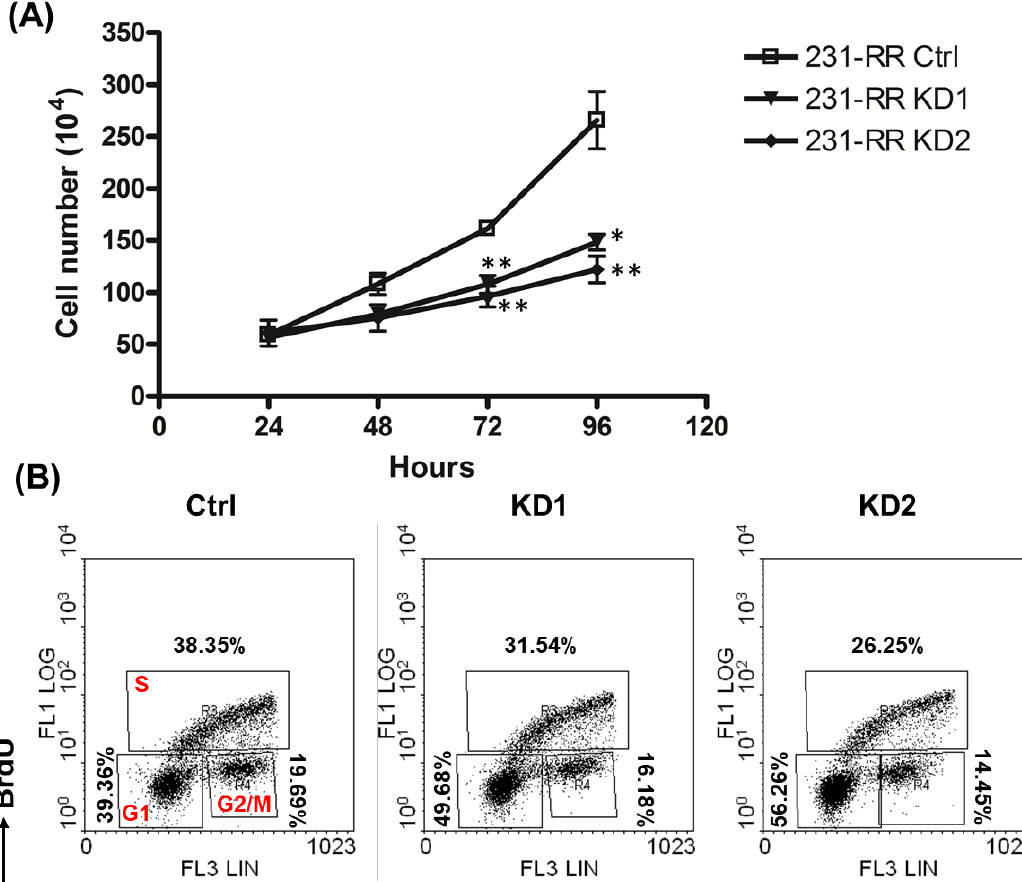
Figure 4. TRIB3 regulated cell growth and cell cycle progression in radioresistant MDA-MB-231 cells.